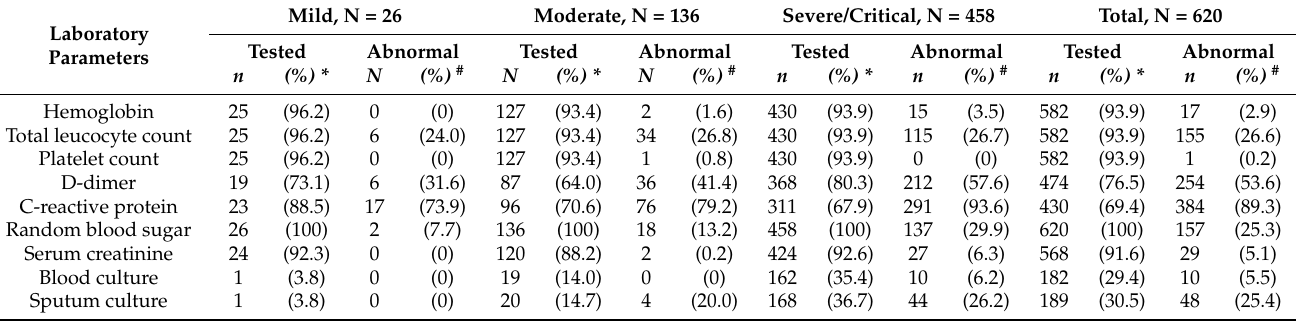
Table 3. Uptake of laboratory investigations and their findings in COVID-19 patients (stratified by severity of illness) admitted in a tertiary teaching hospital of Nepal from April to September